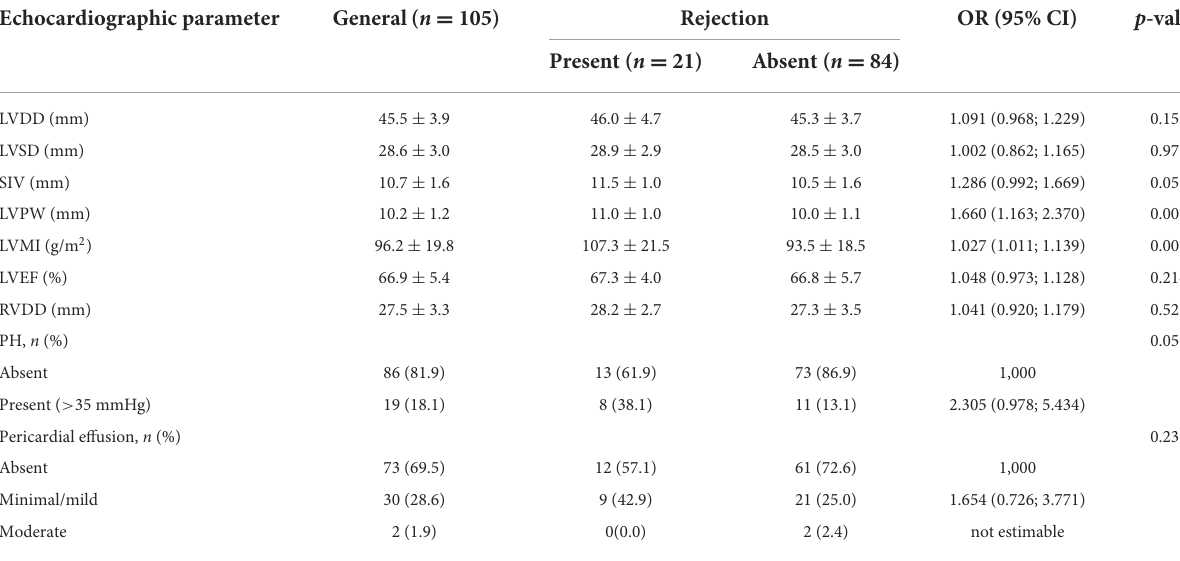
TABLE 2 Conventional echocardiographic parameters obtained by two-dimensional and descriptive evaluation according to rejection. Echocardiographic parameter